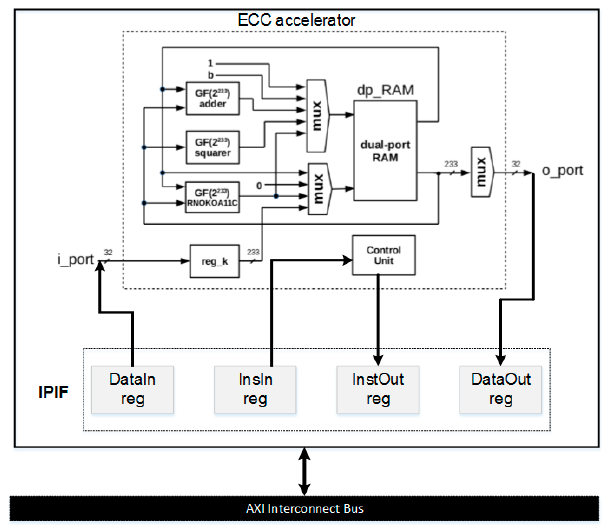
Figure 6. Integration of ECC accelerator with AXI (Advanced eXtensible Interface) bus.